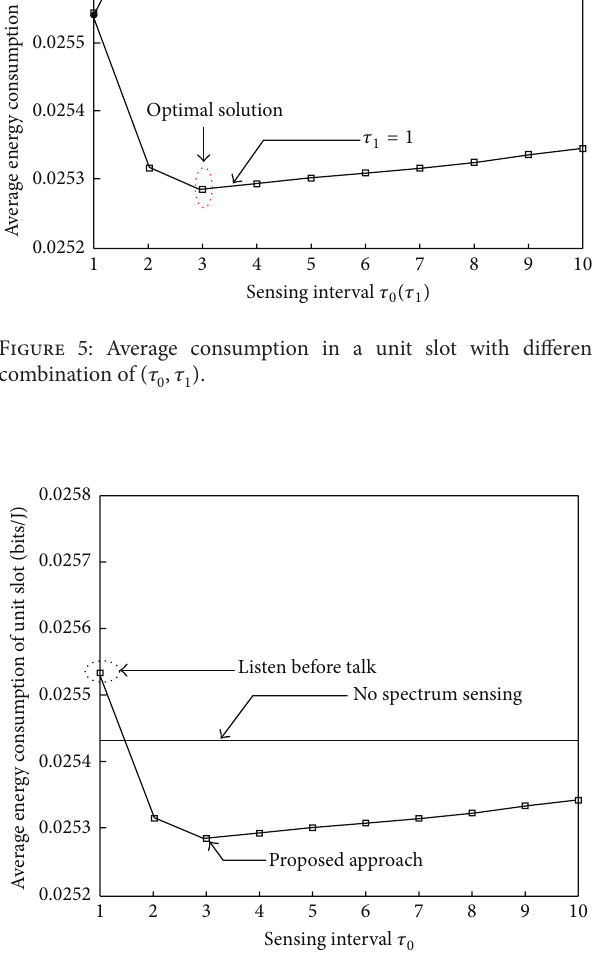
Figure 6: Comparison between “listen before talk” approach and without spectrum sensing approach.